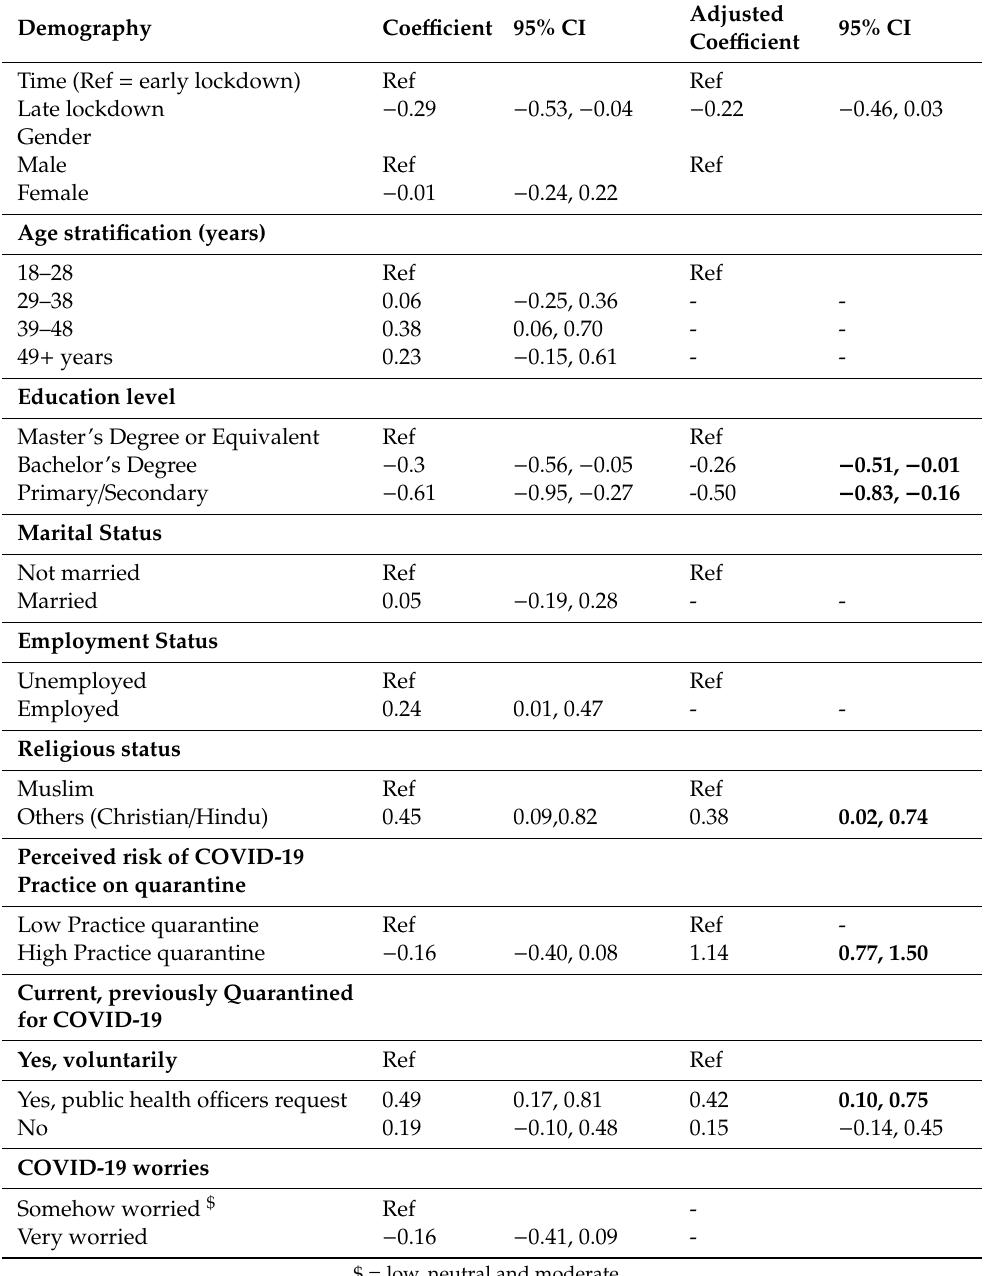
Table 4. Factors associated with the knowledge level of COVID-19 among the respondents in Bangladesh during the lockdown period. (Bold indicates a significant